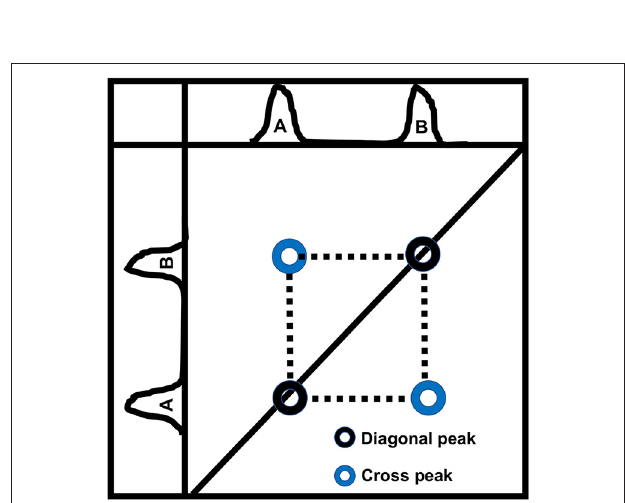
FIGURE 4 | A schematic diagram showing a typical 2D-COSY spectrum. Two types of peaks are observed. Auto peak/diagonal peak indicates that protons from a chemical moiety are not J-coupled with protons of a neighboring moiety. Cross-peak/off-diagonal peak indicates spin-spin couplings between two protons up to three bonds apart (vicinal